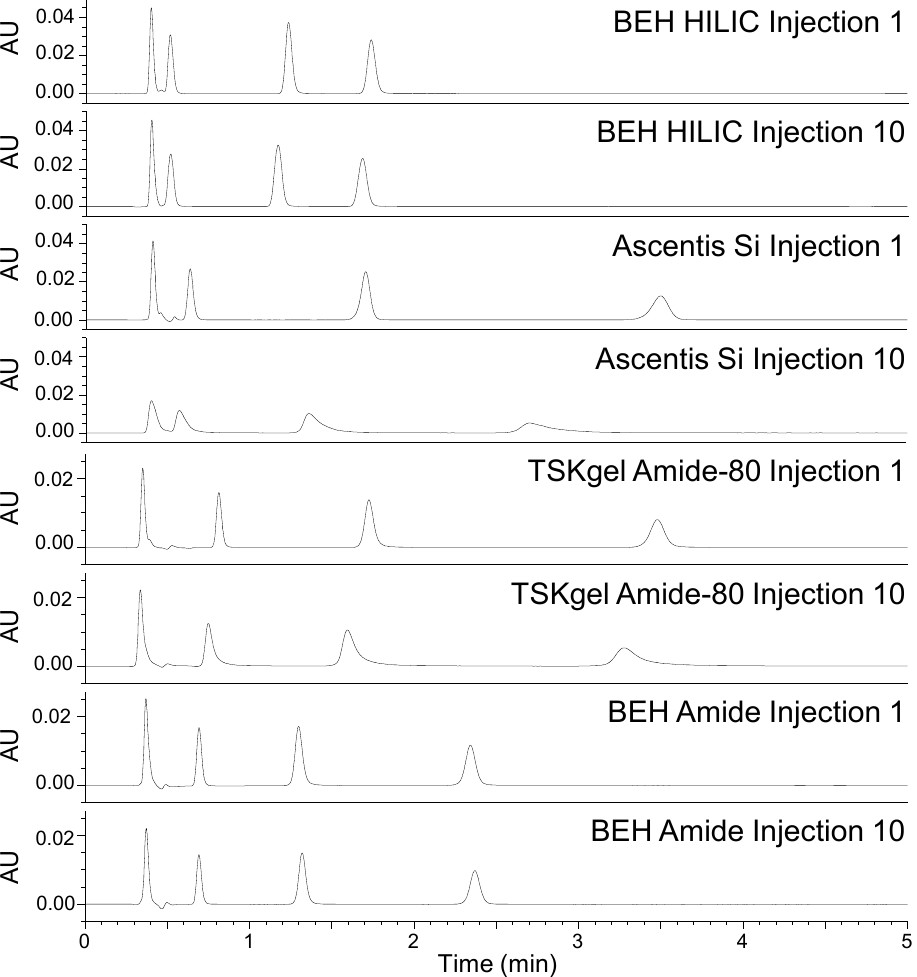
Figure 5. Representative chromatograms for BEH HILIC, Ascentis Si, TSKgel Amide-80 and BEH Amide columns before (injection 1) and after (injection 10) accelerated base stability testing using the conditions described in Figure 4. Peak identification, left to right: acenaphthene, thymine, ade- nine, cytosine.